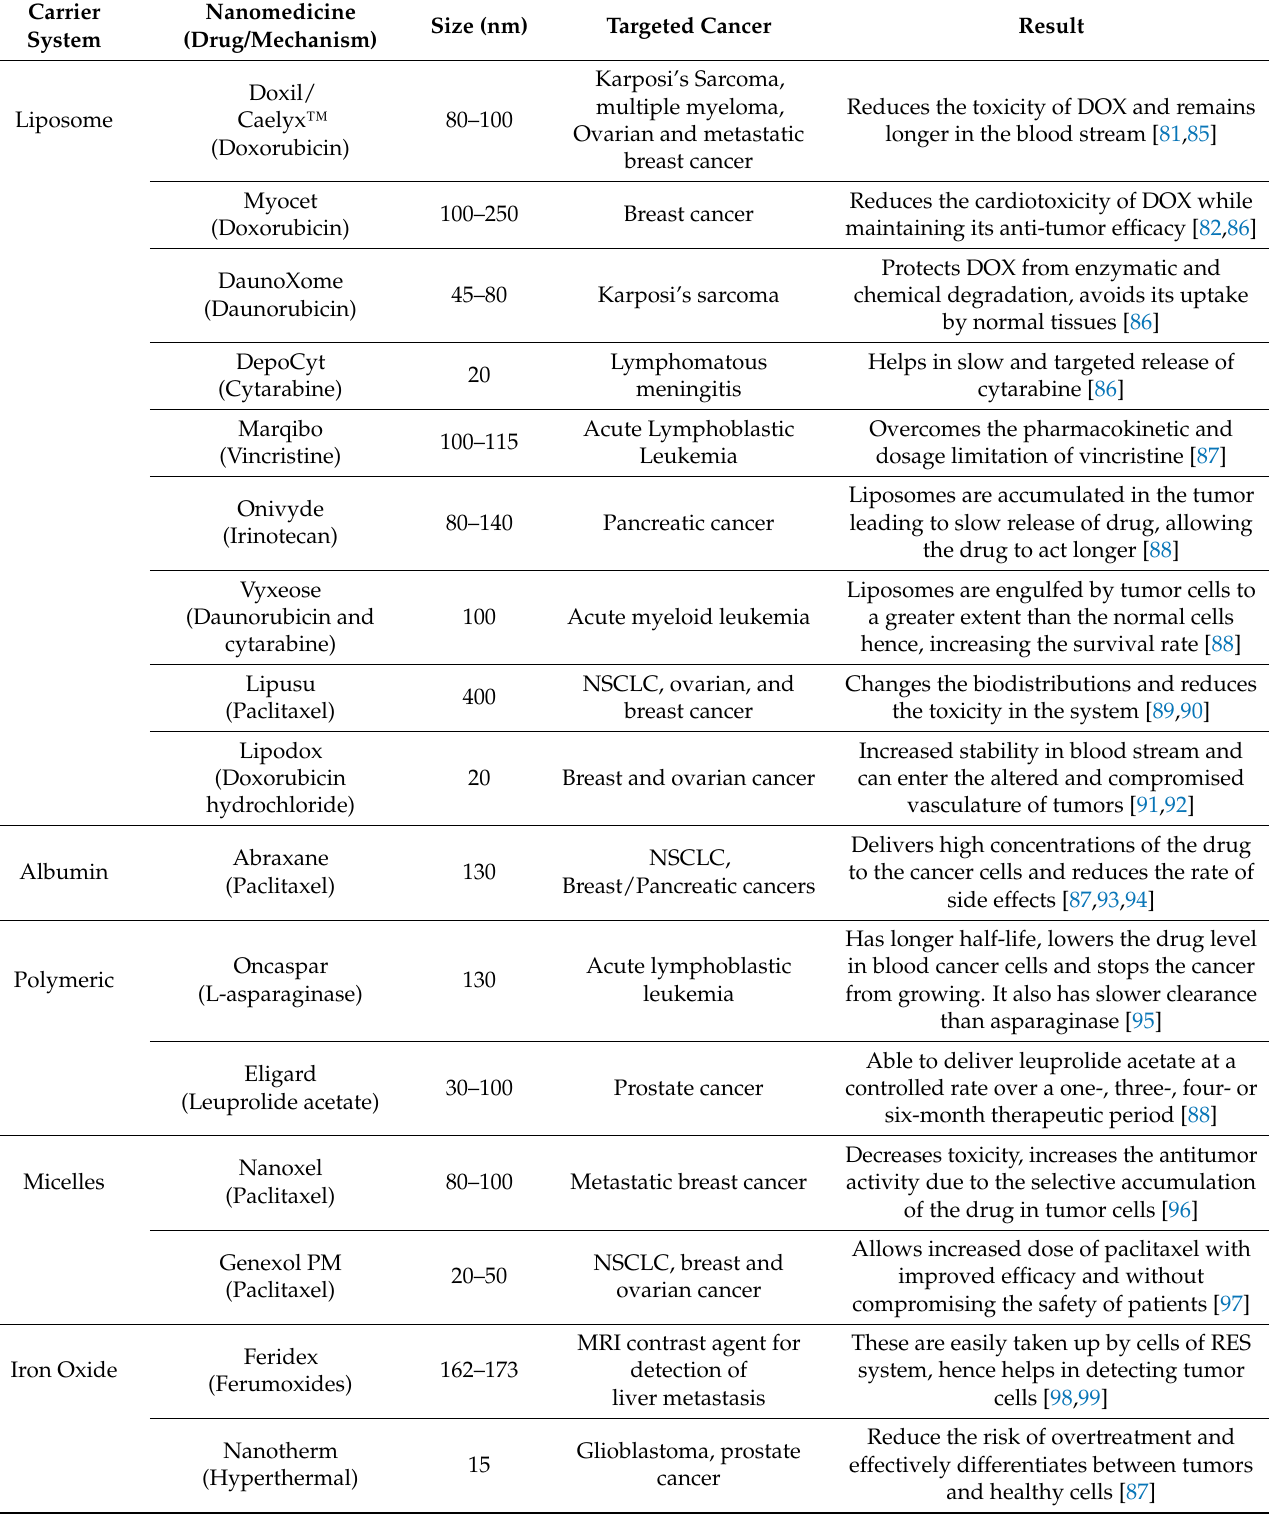
Table 1. List of FDA approved nanomedicines for cancer